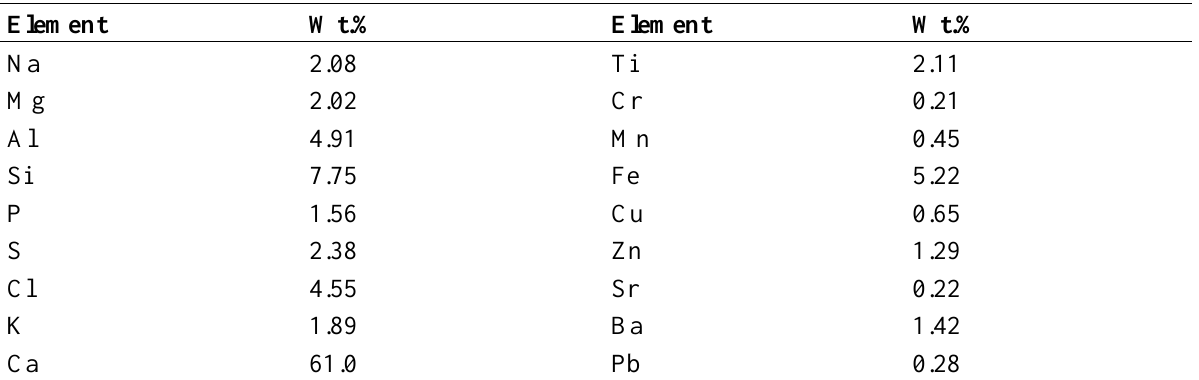
Table 6. Chemical components (wt. %) of the MSWI bottom ash sample analyzed by X-ray fluorescence (XRF) (unpublished data).